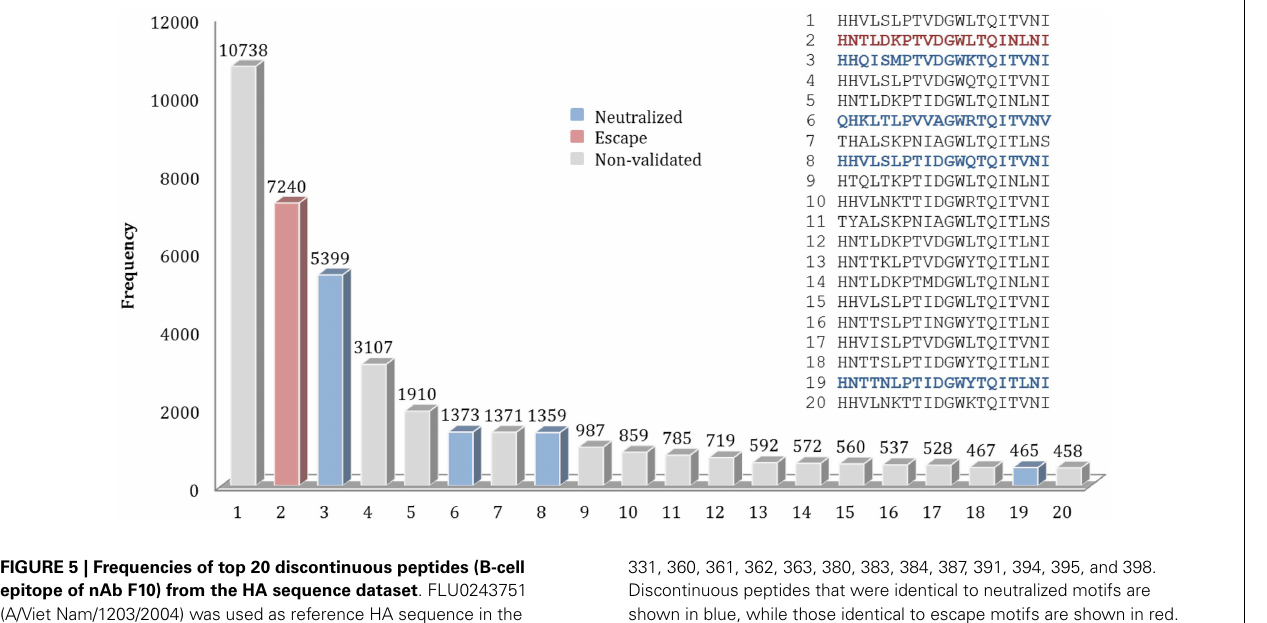
331, 360, 361, 362, 363, 380, 383, 384, 387, 391, 394, 395, and 398. Discontinuous peptides that were identical to neutralized motifs are shown in blue, while those identical to escape motifs are shown in red. The sequences ofTop 20 most frequent discontinuous peptides are listed along with their validation